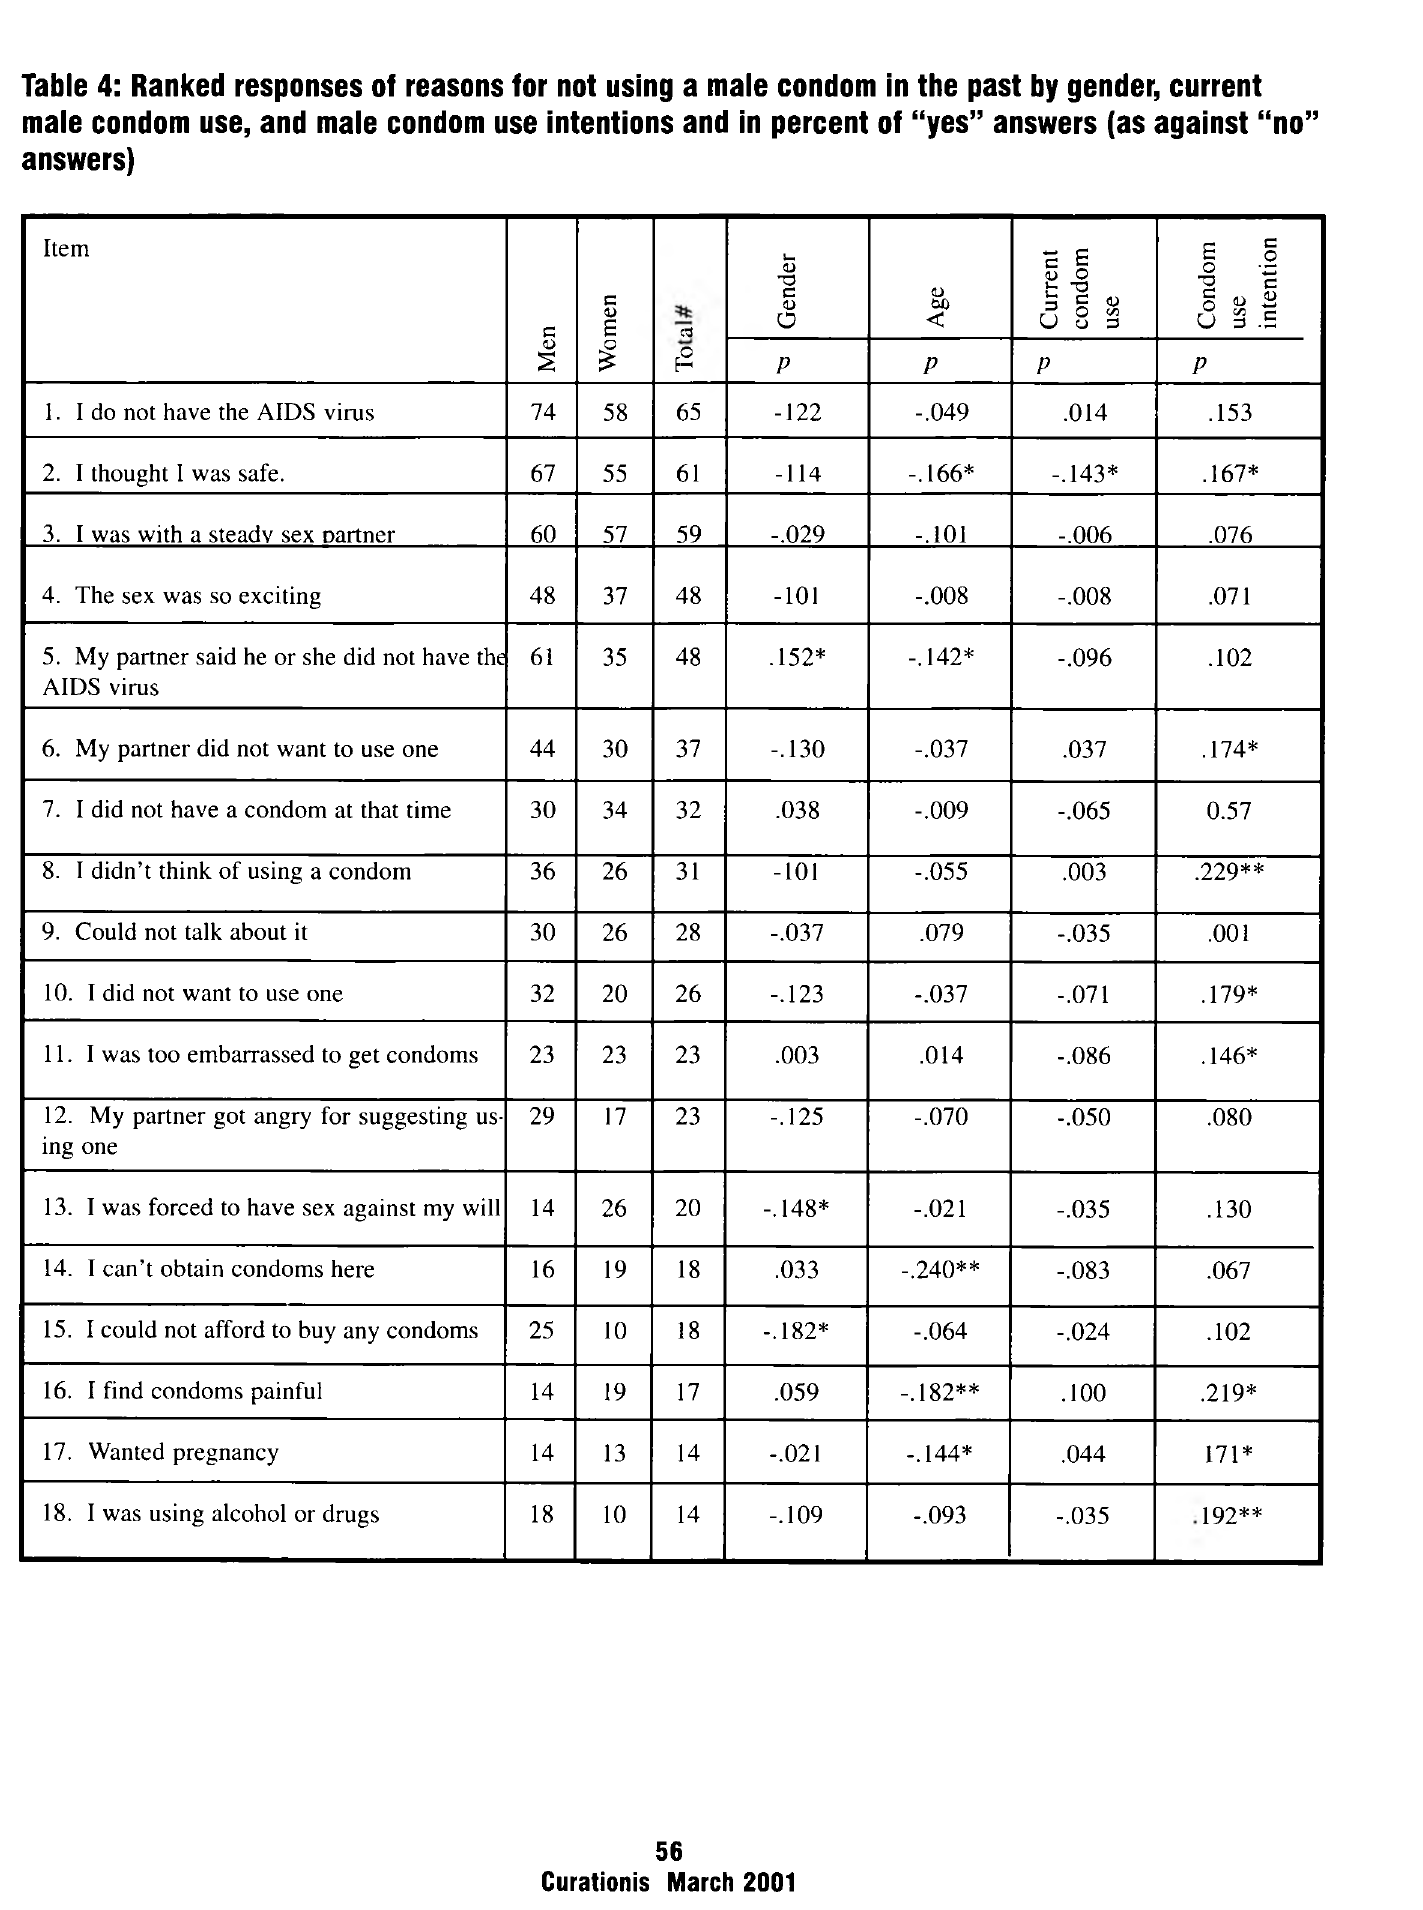
Table 4: Ranked responses of reasons for not using a male condom in the past by gender, current male condom use, and male condom use intentions and in percent of “ yes” answers (as against “ no”